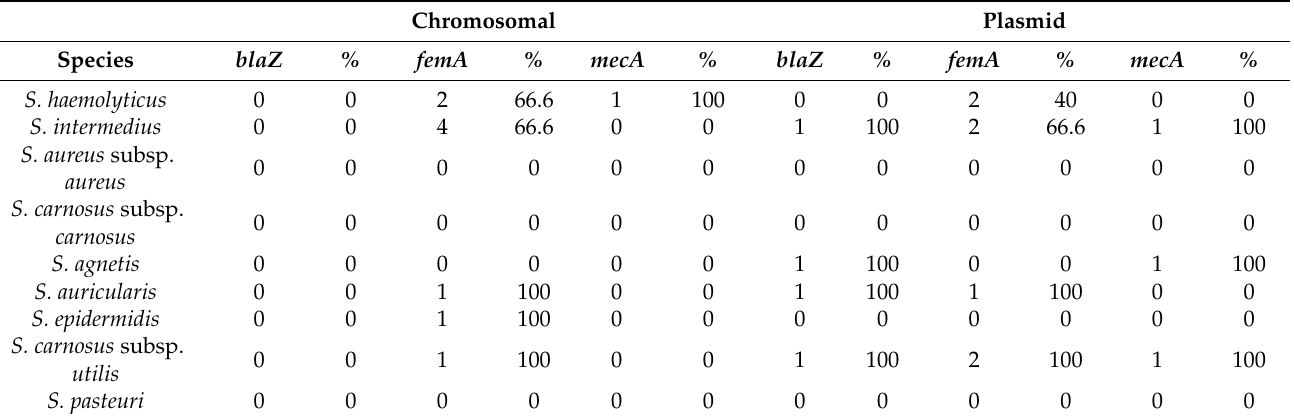
Table 2. Isolates resistant to oxacillin and positive for the genes blaZ , femA , and mecA . Chromosomal Plasmid